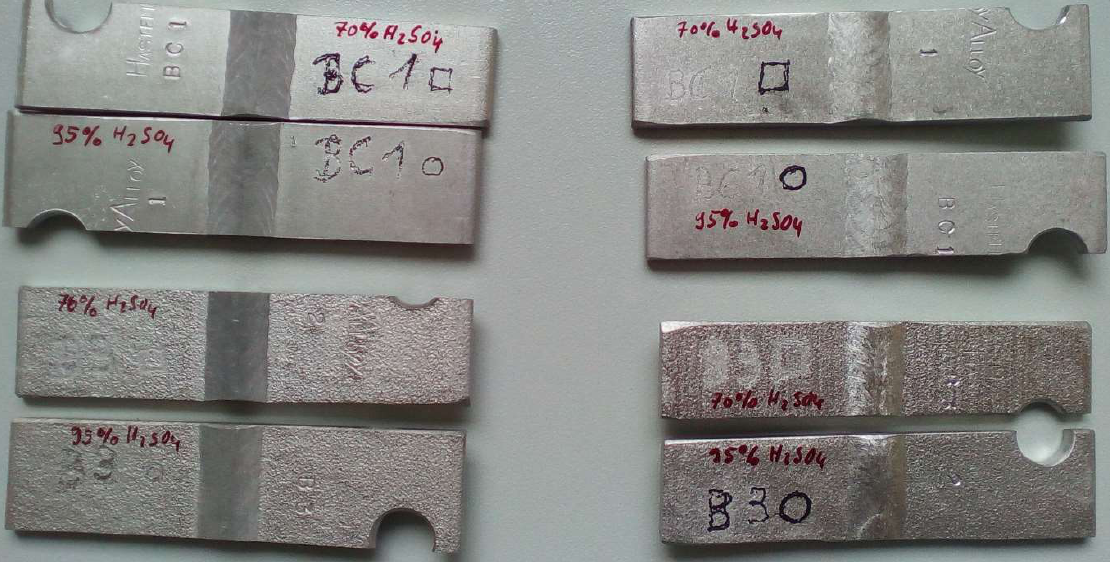
Figure 5. Test specimens after corrosion tests. Left: Condition as delivered. Right: Heat-treated (T = 1100 ◦ C, t = 4 h). Top: Hastelloy BC-1. Bottom: Hastelloy B3. Table 4. Results of corrosion experiments of coupons aged in 70% sulfuric acid.